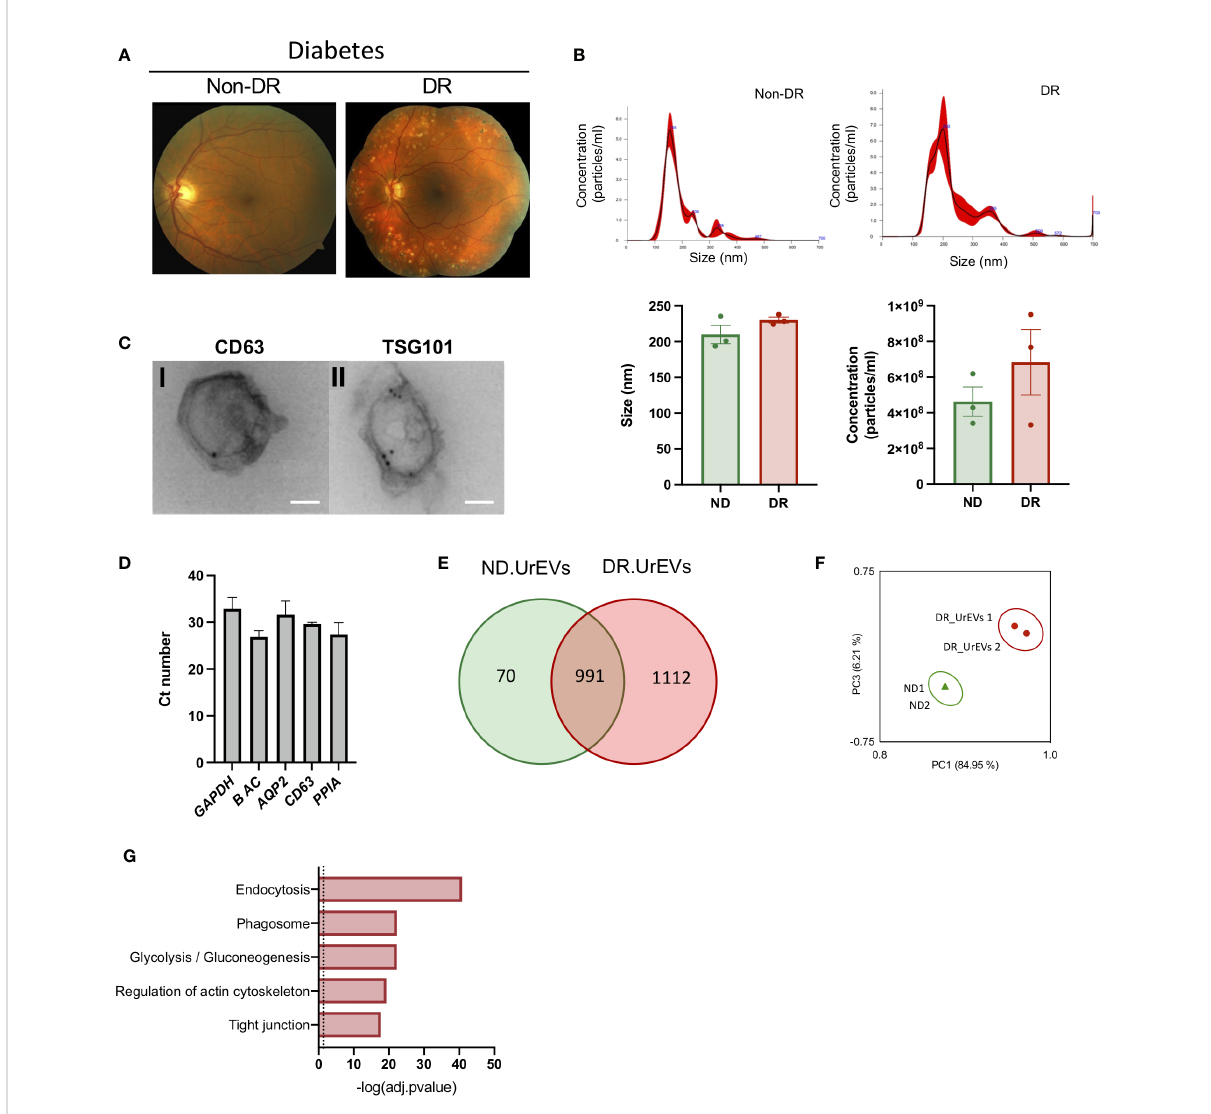
FIGURE 3 Human urine EVs from diabetic patients contain canonical EV markers and genetic cargo. (A) A) Representative Fundus images of Diabetic No DR (left panel) and Diabetic moderate non-proliferative diabetic retinopathy. (Right panel). (B) Representative nanoparticle tracking analysis of urinary EVs (upper panel). Average size and concentration of urinary EVs released from Non-DR and DR patients (bottom panel). Size Student ’ s t-test, p = 0.211, concentration Student ’ s t-test, p = 0.3341 (C) Immunogold representative TEM imaging of EVs isolated from human urine, labeled for CD63 (left panel) and TSG 101 (right panel). Scale: 100nm. (D) qPCR analysis reveals the presence of CD63 and urinary markers AQP2 and Cyclophillin A in Urinary EVs. (E) Venn diagrams showing shared proteins between ND.UrEVs and DR.UrEVs. (F) PCA scatter plot comparing the proteomes of ND.UrEVs and DR.UrEVs. (G) Pathway enrichment analysis of exclusive proteins in